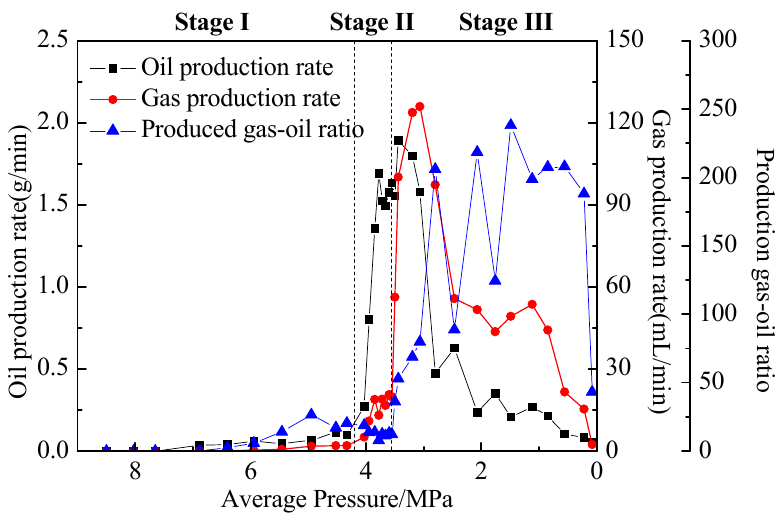
Figure 5. Characteristics for weak foamy oil depletion development (taking test 7 as an example).